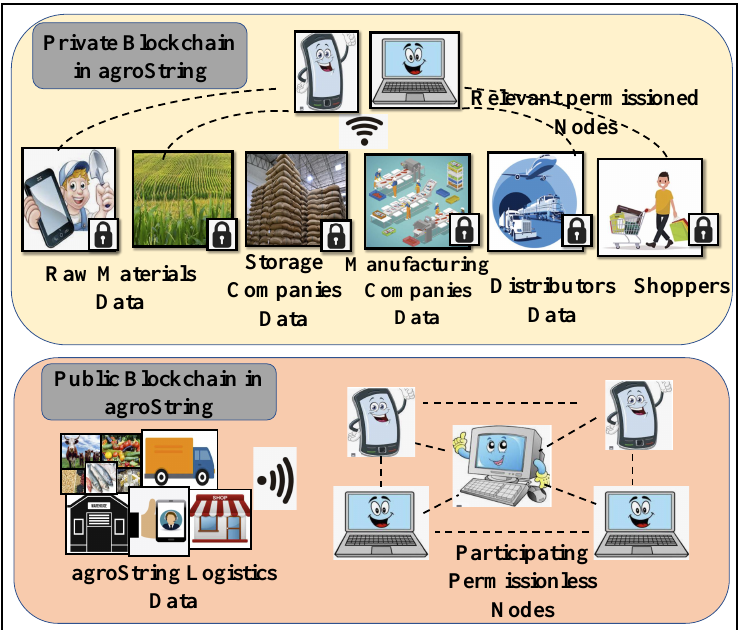
Figure 6. Comparison between private and public blockchains in supply